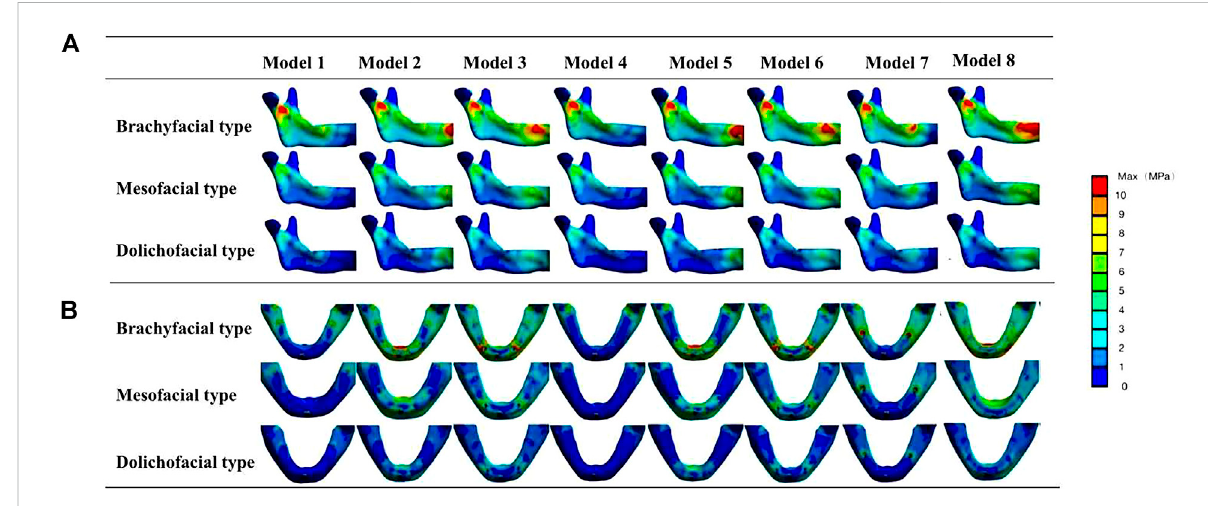
FIGURE 5 Von Mises stresses in the mandible of different facial types. (A) Inside view of the mandibular ascending ramus. (B) Occlusal view of the mandibular body. The stress peak values of the mandible mainly appear at the mandibular median joint, below the sigmoid notch of the mandibular ascending ramus and at the bone interface of the implants.